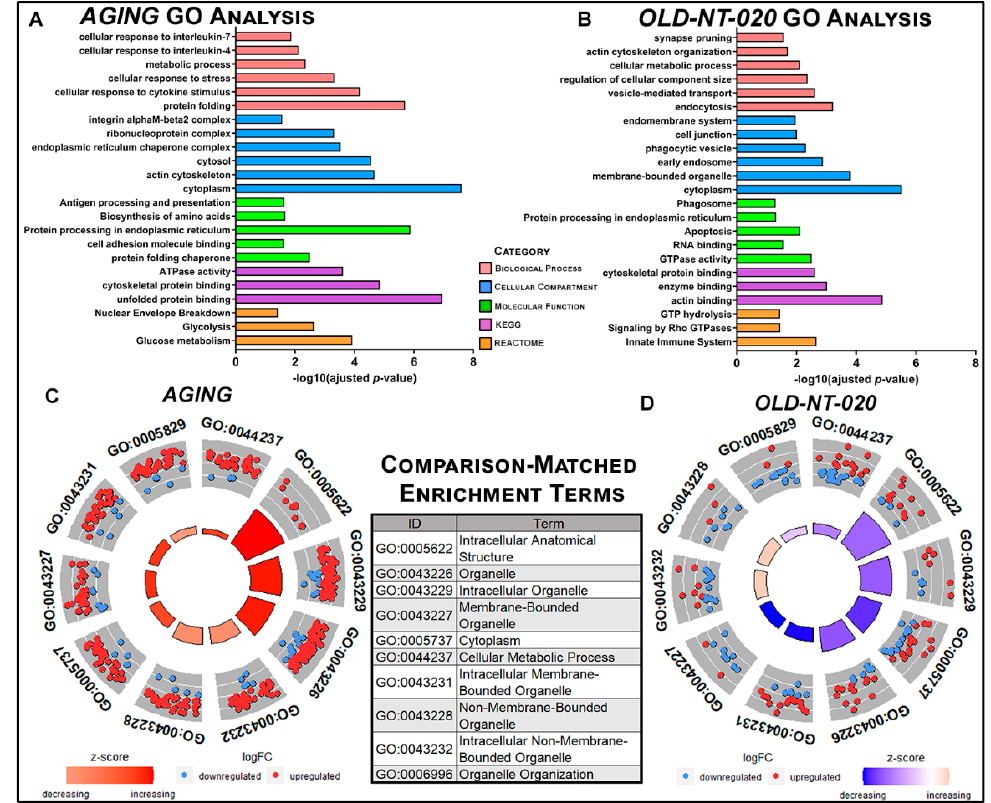
Figure 2. Gene ontology analysis in differentially expressed microglial proteins in AGING and OLD-NT-020 comparisons. Representative GO results queried in g: Profiler for AGING ( A ) and OLD-NT-020 ( B ) comparisons. Terms on vertical axis faceted among biological process, molecular function, cellular compartment and annotations in KEGG and REACTOME pathways. Significance of terms is plotted on the horizontal axis using − log 10 (adjusted p -value). Circle plots generated with the GOCircle function for top 10 enrichment terms by z-score shared by AGING ( C ) and OLD-NT-020 ( D ) comparisons. Outer circle scatterplot represents log 2 (fold-change) of proteins annotated to terms; red circles = upregulation, blue circles = downregulation. Inner bars depict z-score (calculated as (# (cid:3042)(cid:3033) (cid:3048)(cid:3043)(cid:3045)(cid:3032)(cid:3034)(cid:3048)(cid:3028)(cid:3039)(cid:3047)(cid:3032)(cid:3031) (cid:3043)(cid:3045)(cid:3042)(cid:3047)(cid:3032)(cid:3036)(cid:3041)(cid:3046)(cid:2879)# (cid:3042)(cid:3033) (cid:3031)(cid:3042)(cid:3050)(cid:3041)(cid:3045)(cid:3032)(cid:3034)(cid:3048)(cid:3039)(cid:3028)(cid:3047)(cid:3032)(cid:3031) (cid:3043)(cid:3045)(cid:3042)(cid:3047)(cid:3032)(cid:3036)(cid:3041)(cid:3046)) (cid:3493)# (cid:3042)(cid:3033) (cid:3043)(cid:3045)(cid:3042)(cid:3047)(cid:3032)(cid:3036)(cid:3041)(cid:3046) (cid:3043)(cid:3032)(cid:3045) (cid:3008)(cid:3016) (cid:3047)(cid:3032)(cid:3045)(cid:3040) ) where red = increasing z-score and blue = decreasing z-score. AGING showed marked enrichment for upregulated proteins within terms while OLD-NT-020 trended oppositely.